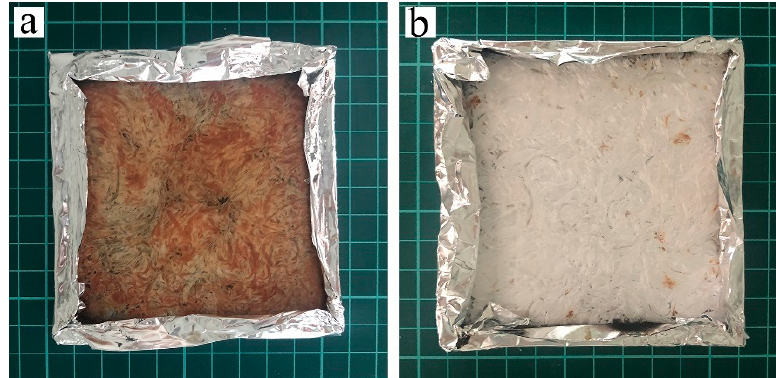
Figure 18. The picture of the ( a ) SPF-4 and ( b ) PF composites after the CC test.